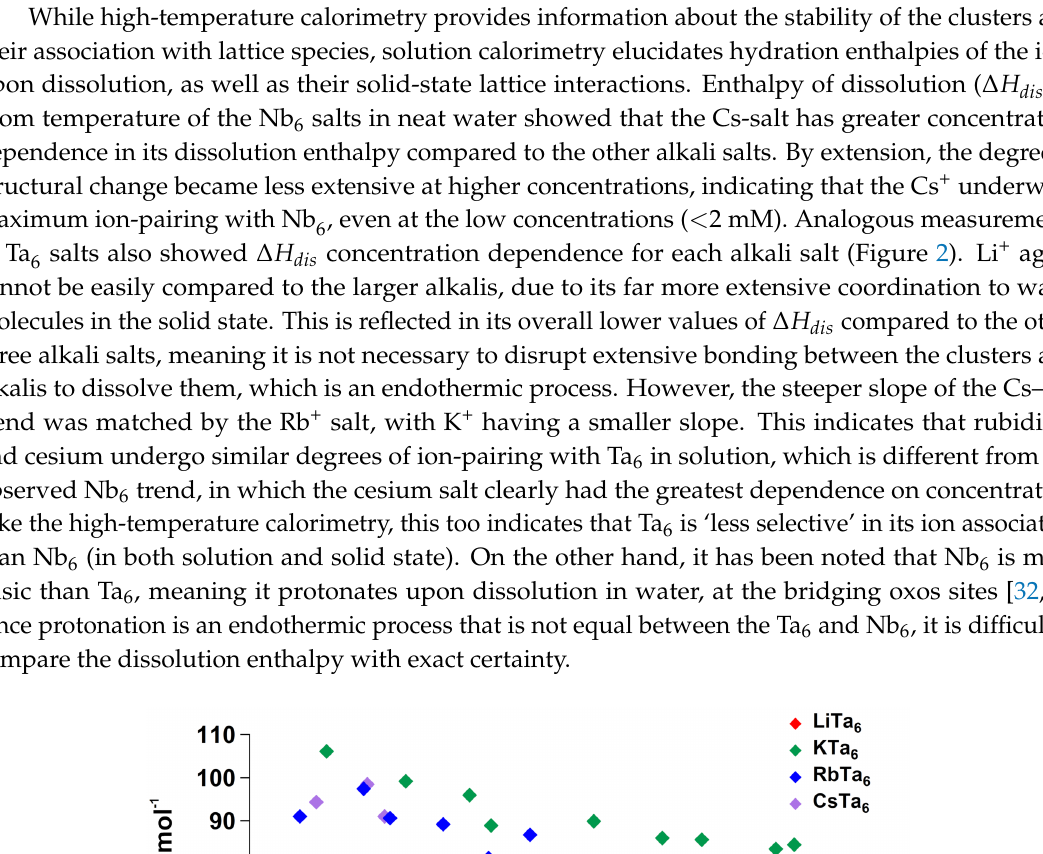
, K–Ta , Rb–Ta and Cs–Ta 6 6 6